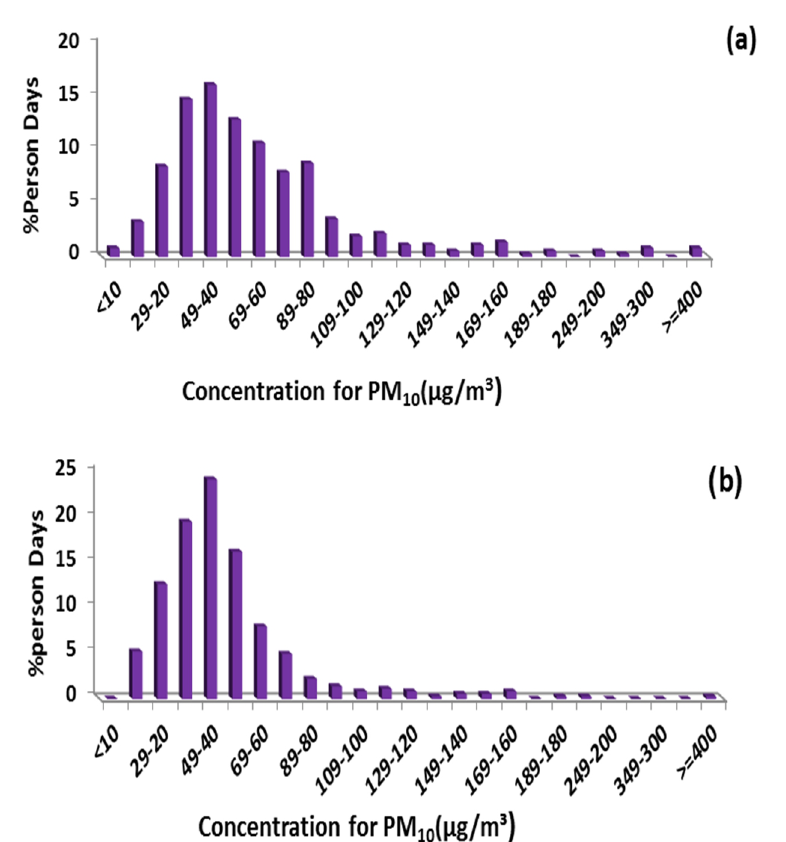
Fig. 3. Percentage of days of exposure to different concentrations of particles with an aerodynamic diameter of residents less than 10 microns in Ilam city in 2013 (a) and 2014 (b) Table 1. Repeated cases (BI), relative risk (RR), the ratio of attributable (AP) estimated annual number of cases Subject to short-term effects of particles with aerodynamic diameter of less than 10 microns Health endpoints Year BI RR